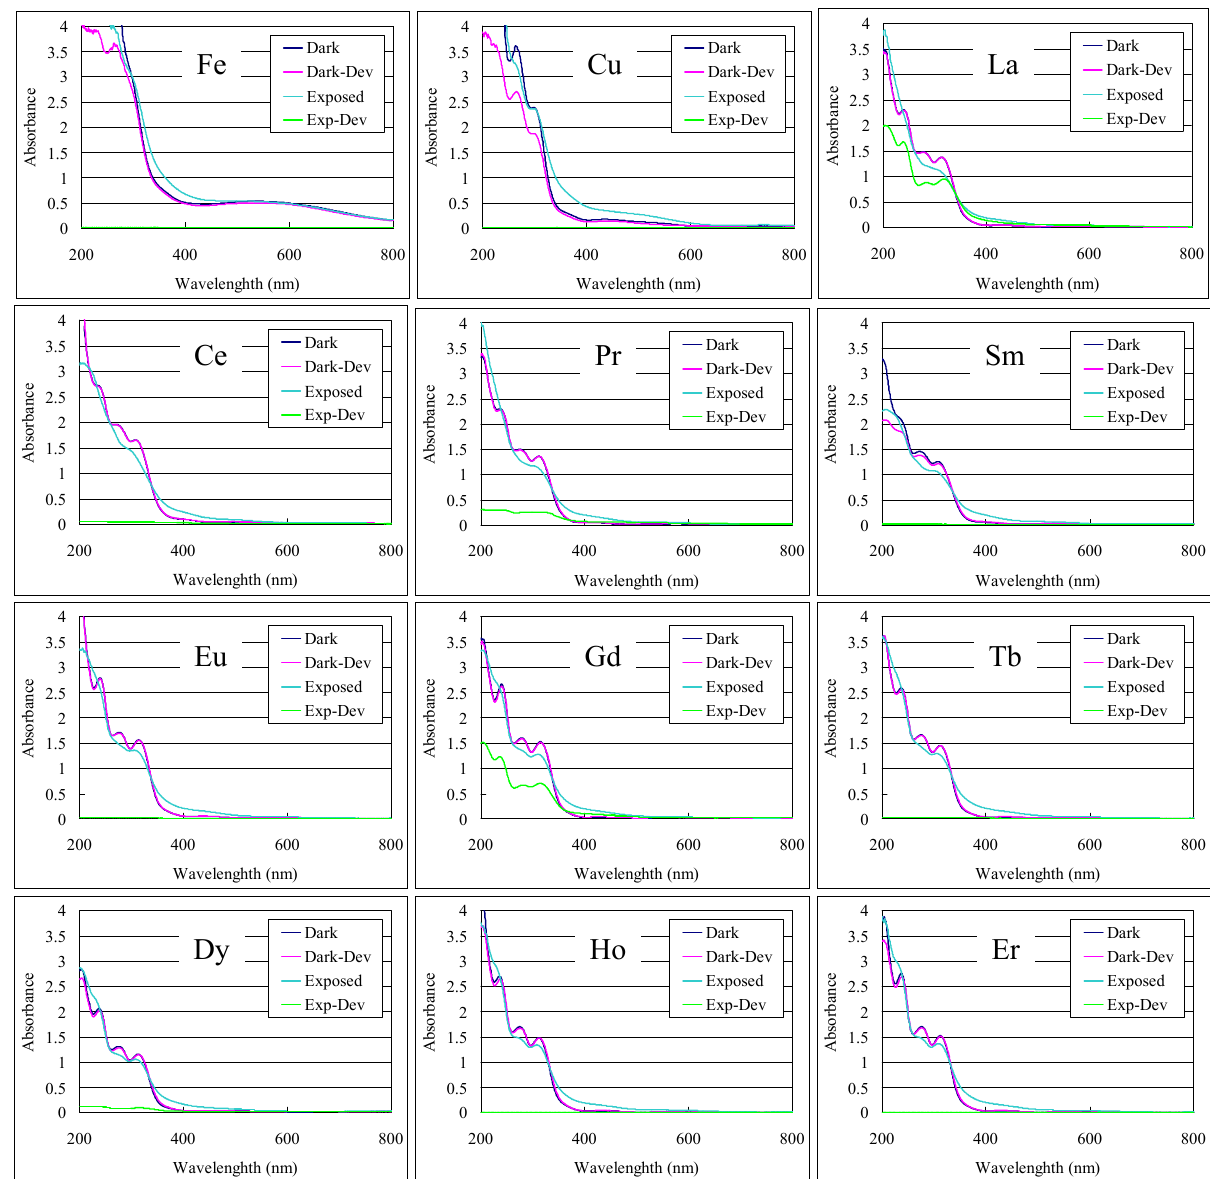
Figure 5. UV-Vis spectra of the masked (Dark) and exposed (Exposed) areas of 1 + metal films before and after developing in 0.25 wt % TMAH